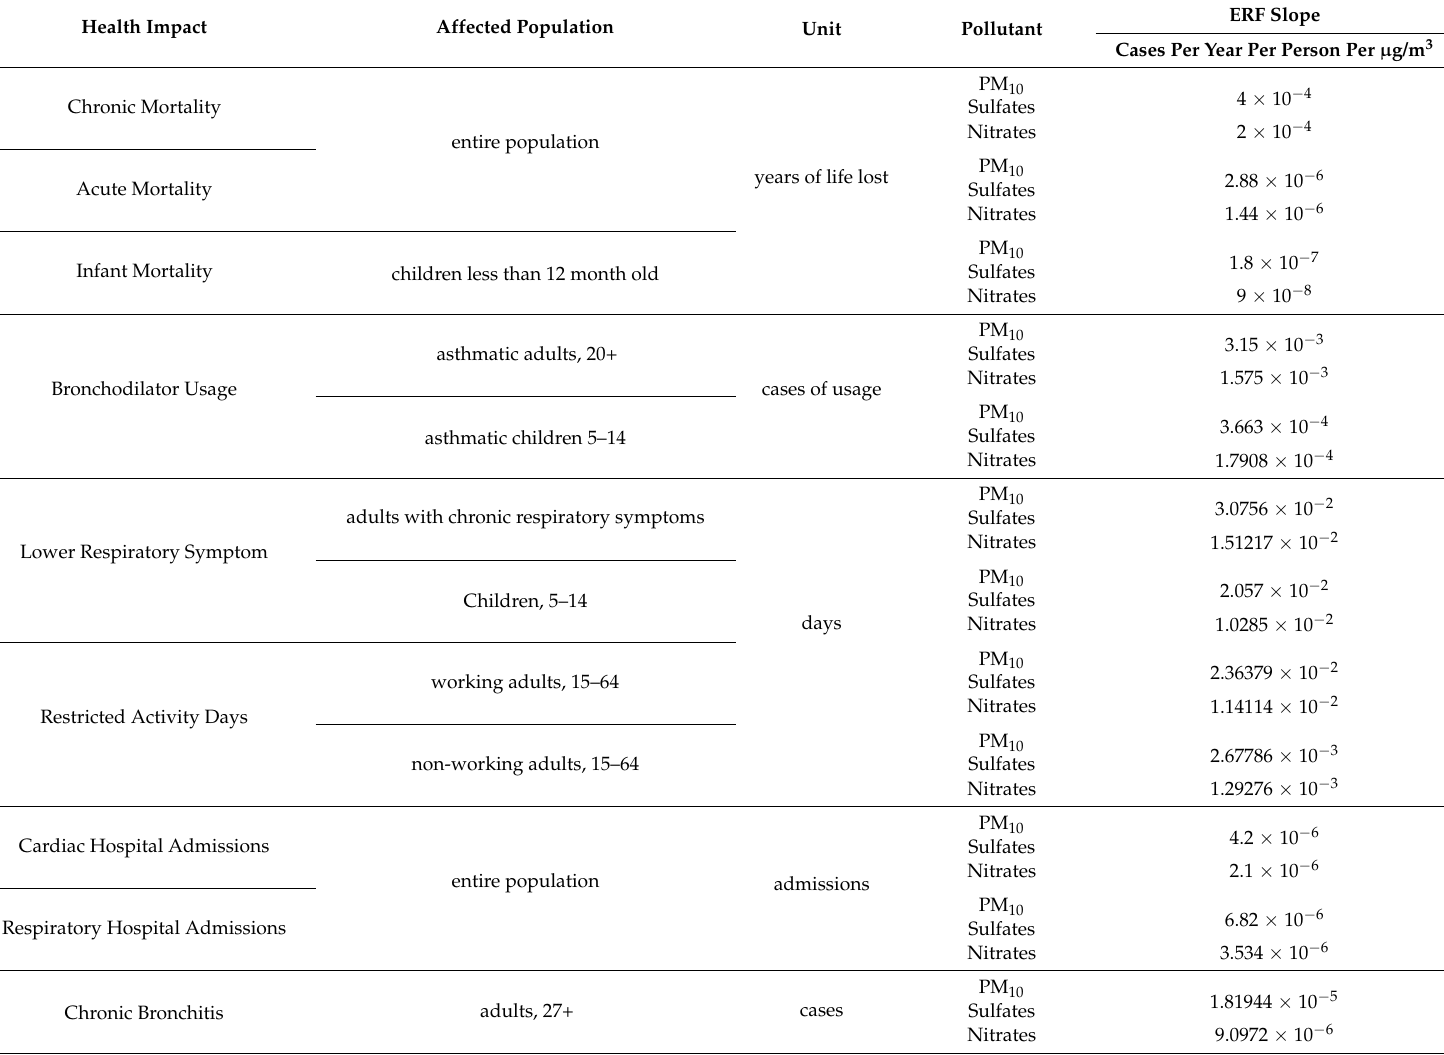
Table A3. Health impacts of pollutants and exposure-response